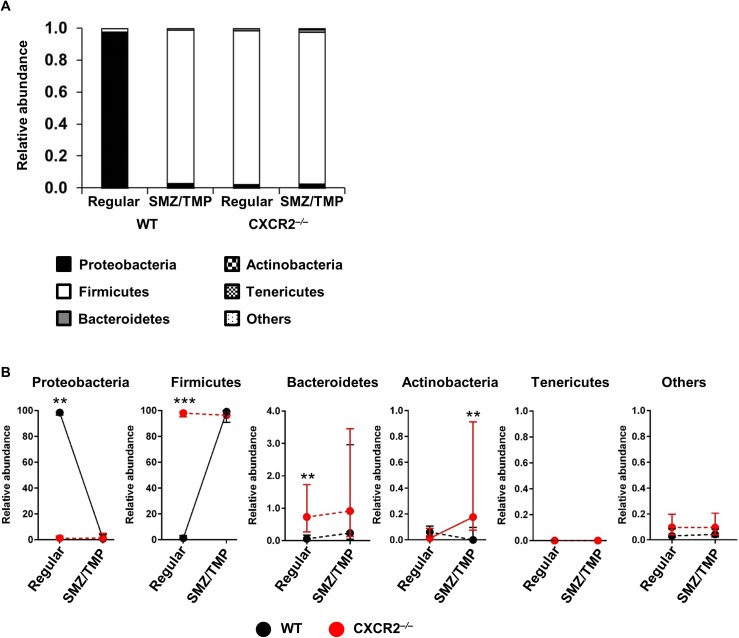
Changes in the intestinal microbiome induced by SMZ/TMP in Cxcr2-/- mice after RRV infection.(A) Phylum analyses show a switch from Proteobacteria to Firmicutes upon exposure to SMZ/TMP or mutation of Cxcr2 (N = 8–13 per group). (B) Colons from the SMZ/TMP-treated Cxcr2-/- mice had less Proteobacteria, more Firmicutes and Actinobacteria (n = 8–13 per group). Median with interquartile ranges in microbiome changes in WT and Cxcr2-/- mice in relation to regular and SMZ/TMP-containing diets (N = 8–13 per group). Solid and dotted lines are defined as statistically significant and non-significant, respectively, between regular and SMZ/TMP diet in each mouse type. *P<0.05; **P<0.01; ***P<0.001; ****P<0.0001.